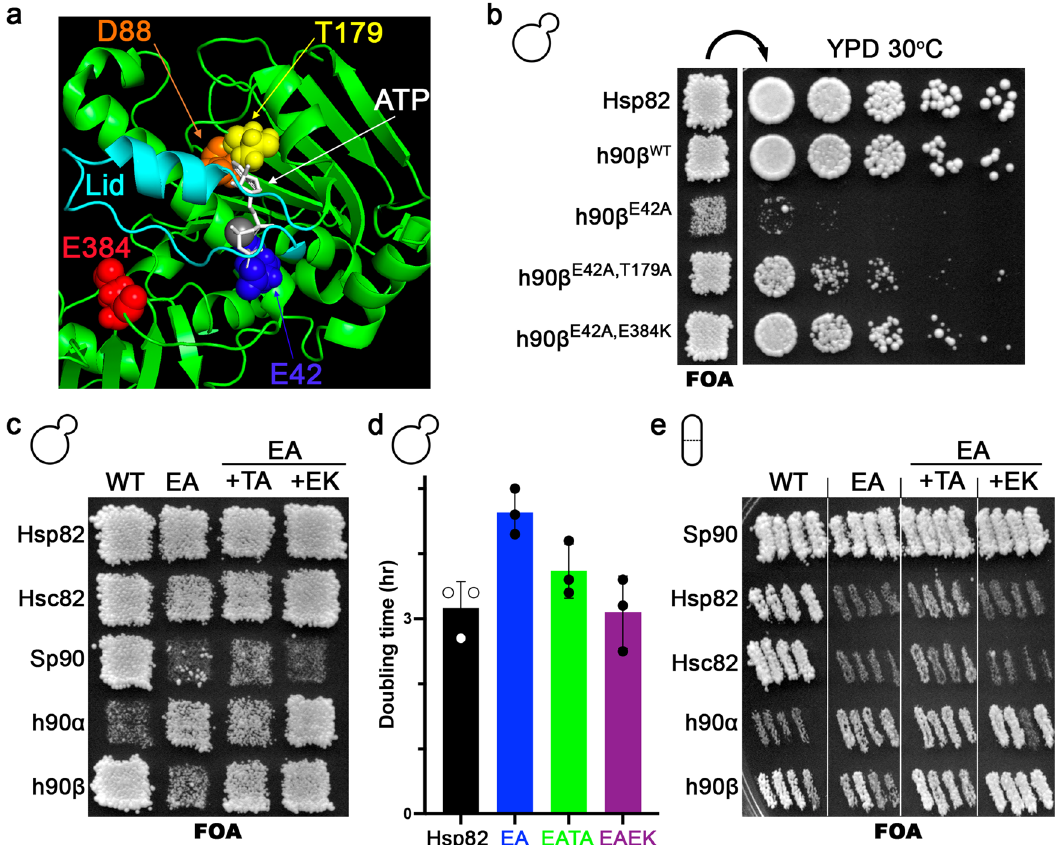
Fig. 4 | Second site mutations rescue the hHsp90 β -EA growth defect and their effects are conserved. a Suppressors of the hHsp90 β -EA growth defect are in or near the ATP binding pocket. T179 (yellow) is next to D88 (orange) and interacts withtheadenosineringofboundnucleotides(white).E384(red)isintheMdomain but comes very close to the lid structure (cyan) in closed Hsp90. E42 (blue) and Mg ++ (graysphere)arealsoshownforreference.hHsp90 β structureisfromPDBID 5fwk 51 . b T179A and E384Kimprovedthe ability of hHsp90 β -EAtosupportviability of S.cerevisiae . c EKimprovedthegrowthof S.cerevisiae cellsexpressinghHsp90 α -